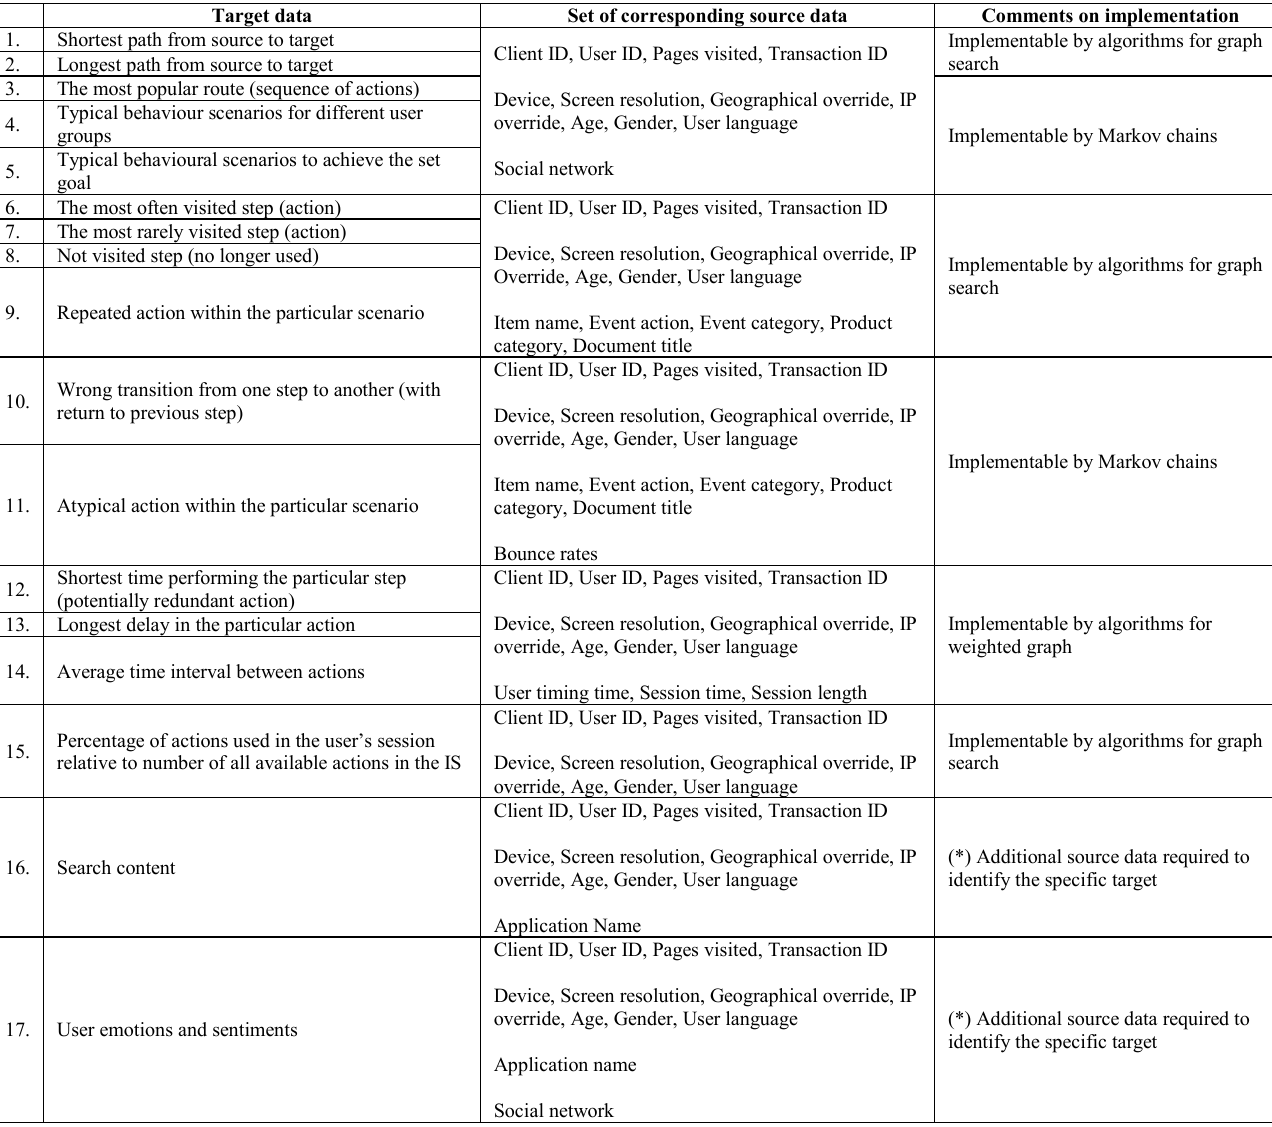
D EPENDENCY D EFINITION B ETWEEN S OURCE AND T ARGET D ATA C OMBINATIONS WITH C OMMENTS FOR T HEIR I MPLEMENTATION Target